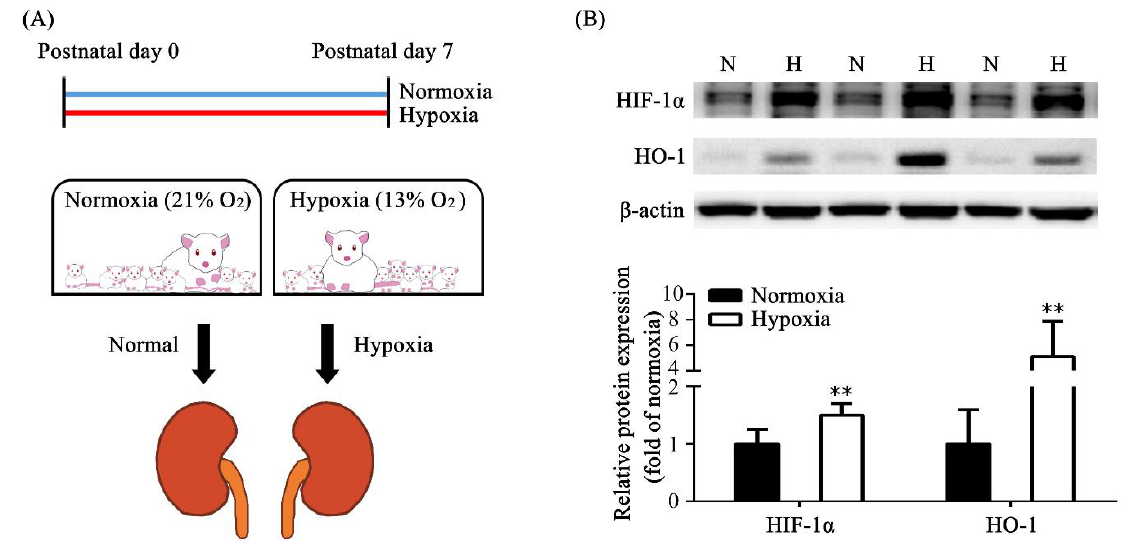
Figure 1. Neonatal rat model of the effect of hypoxia on the kidney after 7 postnatal days. ( A ) Our newborn rat model was used to study the effect of hypoxia on the kidney. ( B ) Protein expressions of HIF-1 α and HO-1 in the kidney tissue of the normoxic and hypoxic groups are shown. The values are presented as mean ± standard deviation, ** p < 0.01, versus the normoxic group. The p -values were estimated via Mann–Whitney U test ( n = 6). N, normoxia; H, hypoxia; HIF-1 α , hypoxia-inducible factors, alpha subunit; HO-1, heme oxygenase-1.